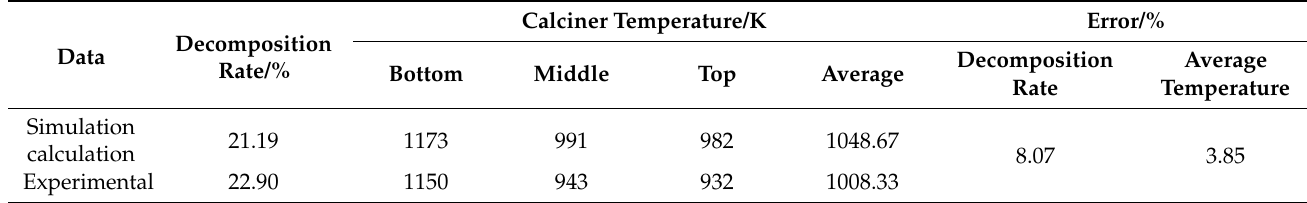
Table 4. Comparison between calculated results and measured data.